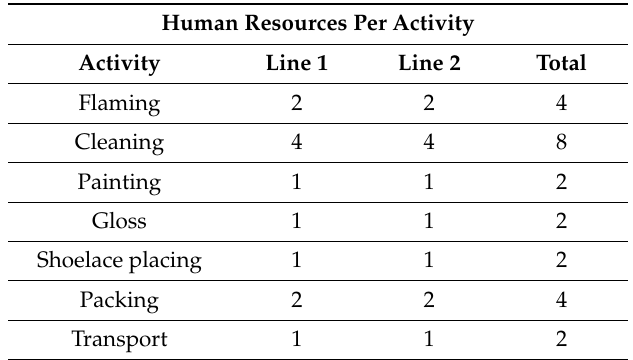
Table 2. Human resources by operation, elaborated by the author.